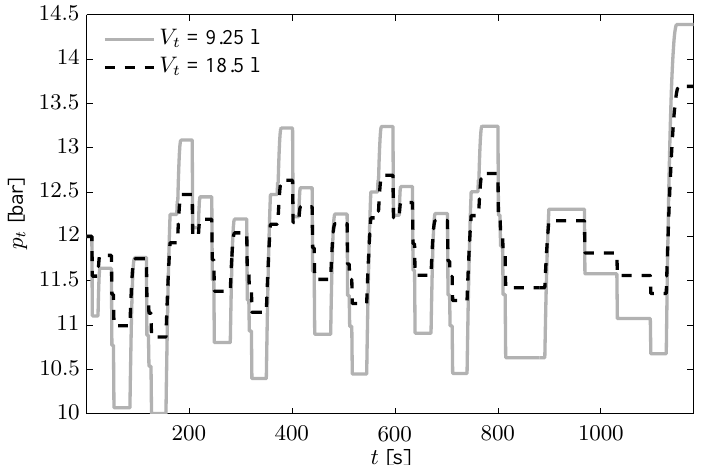
Figure 9. Tank pressure trajectories for two different tank volumes.